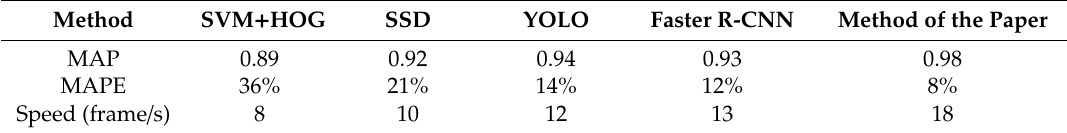
Figure 13. Ship target detection interface. Table 4. Comparisons of